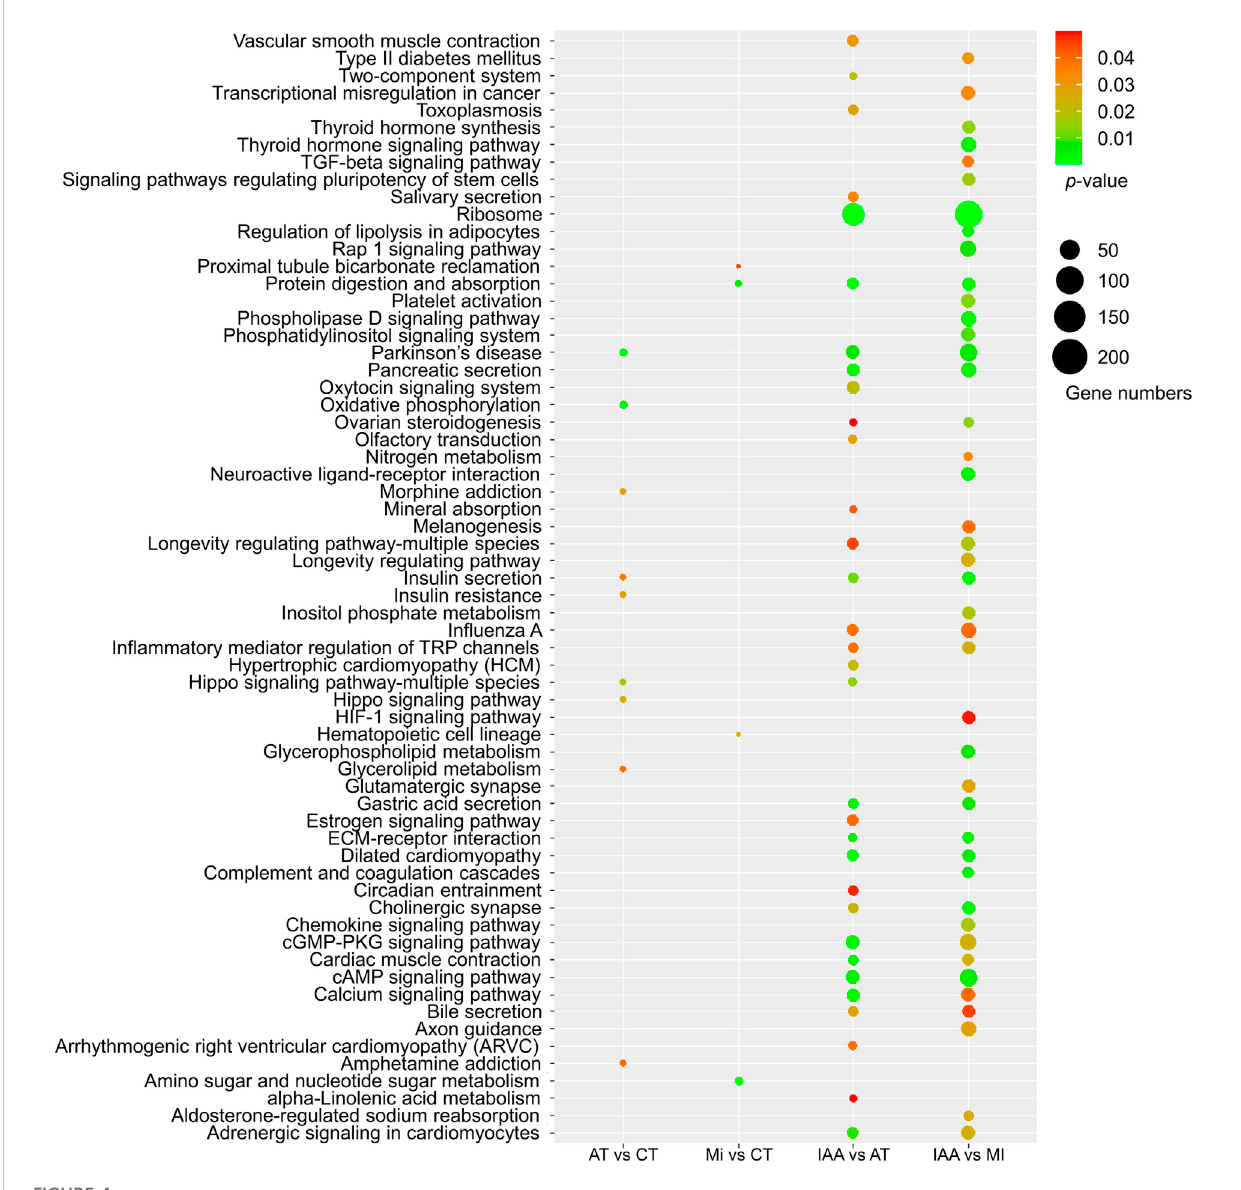
FIGURE 4 KEGG enrichment of DEGs identi fi ed in each comparison group. The size of the dot indicates the number of genes, and the p -value was derived by hypergeometric tests.